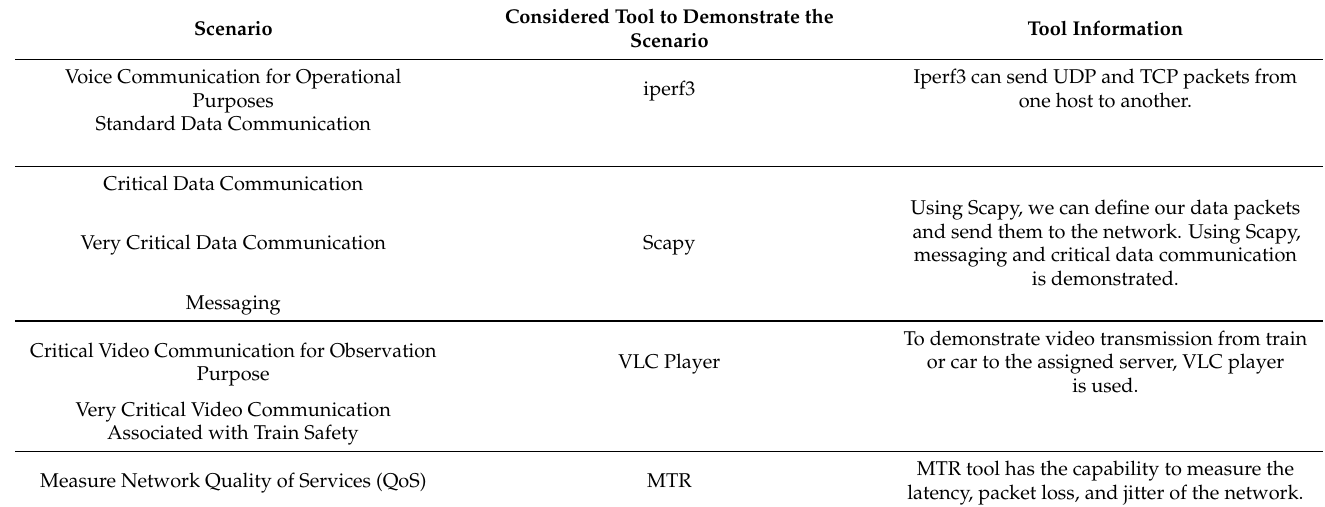
Table 2. Selected tools to generate different kinds of data traffic for compliance with real-case scenario